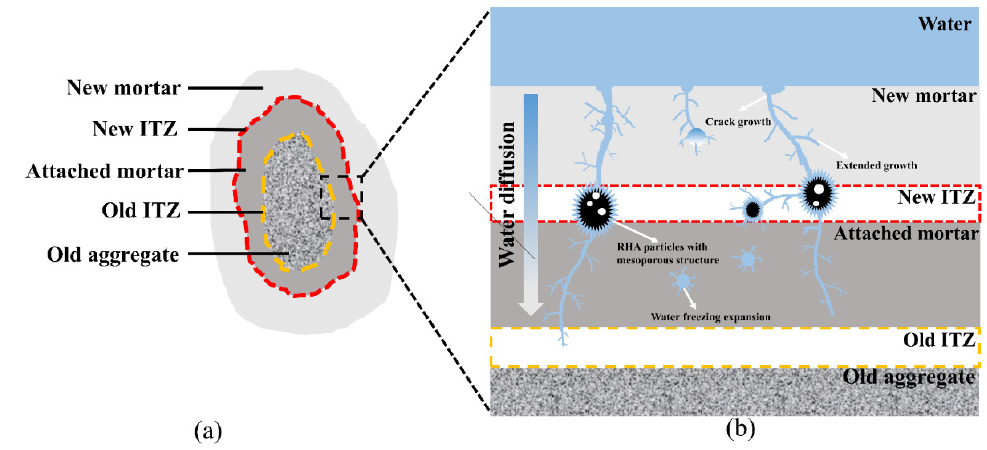
Figure 10. ( a ) Schematic diagram of the component phases of RCA; ( b ) Schematic of the deterioration mechanism of RHA on recycled aggregate concrete freeze–thaw damage.